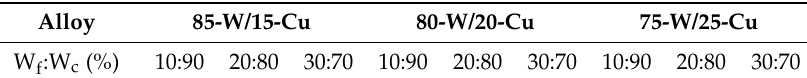
Table 1. Different weight ratios (wt %) of the W bimodal powder combinations (W f :W c ) for the produced W/Cu alloys.